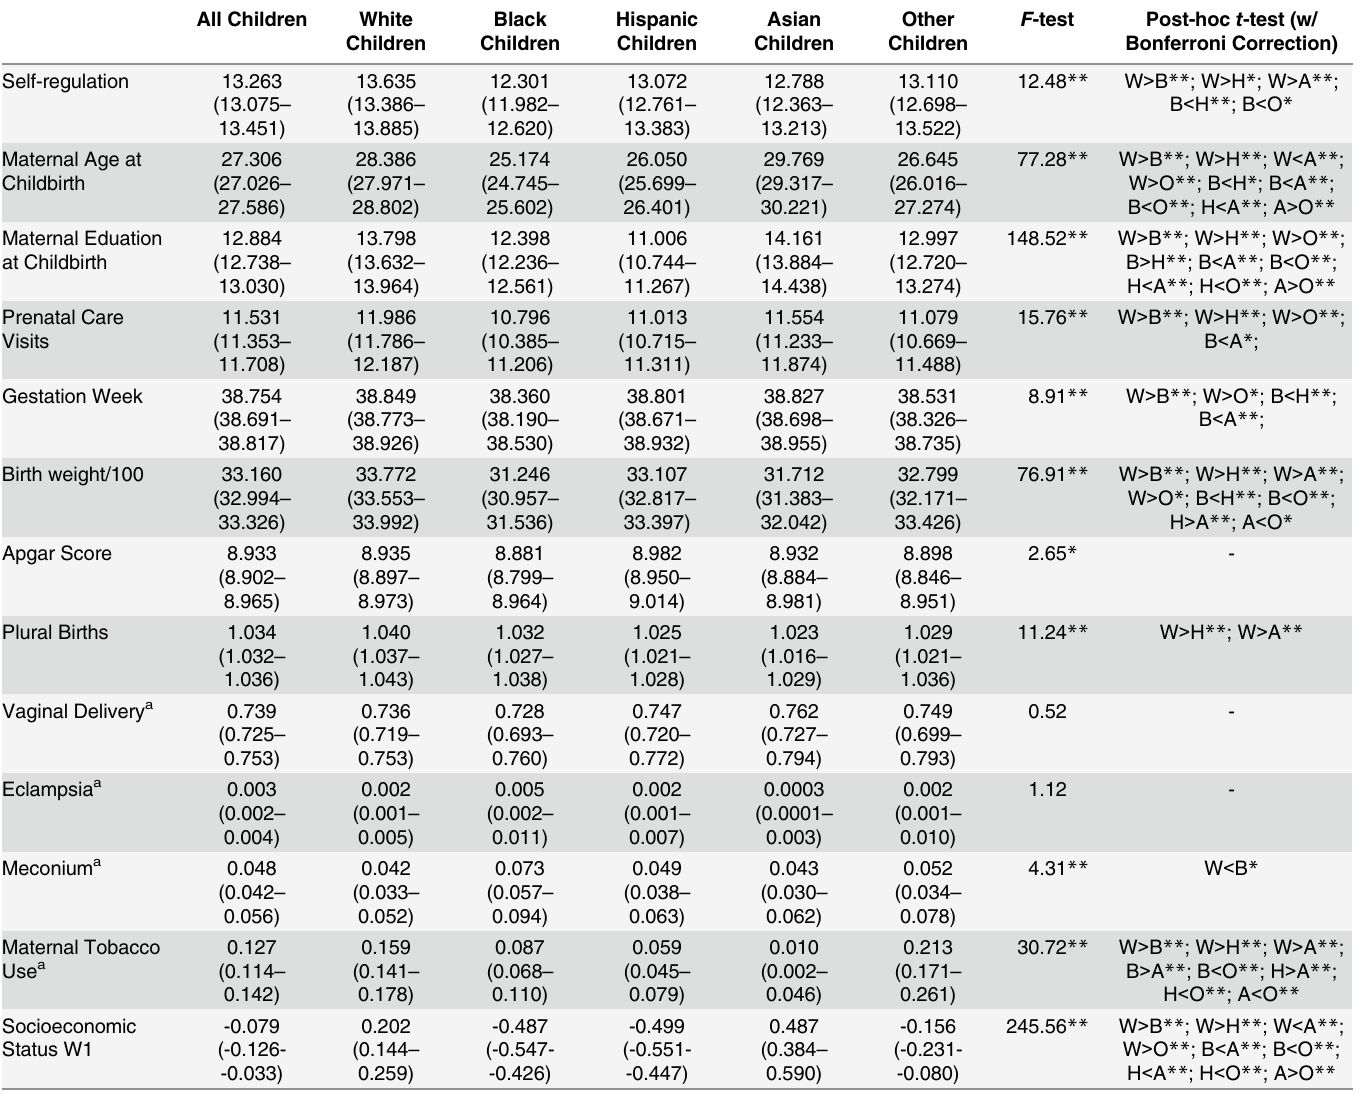
Table 1. Mean Scores for ECLS-B Study